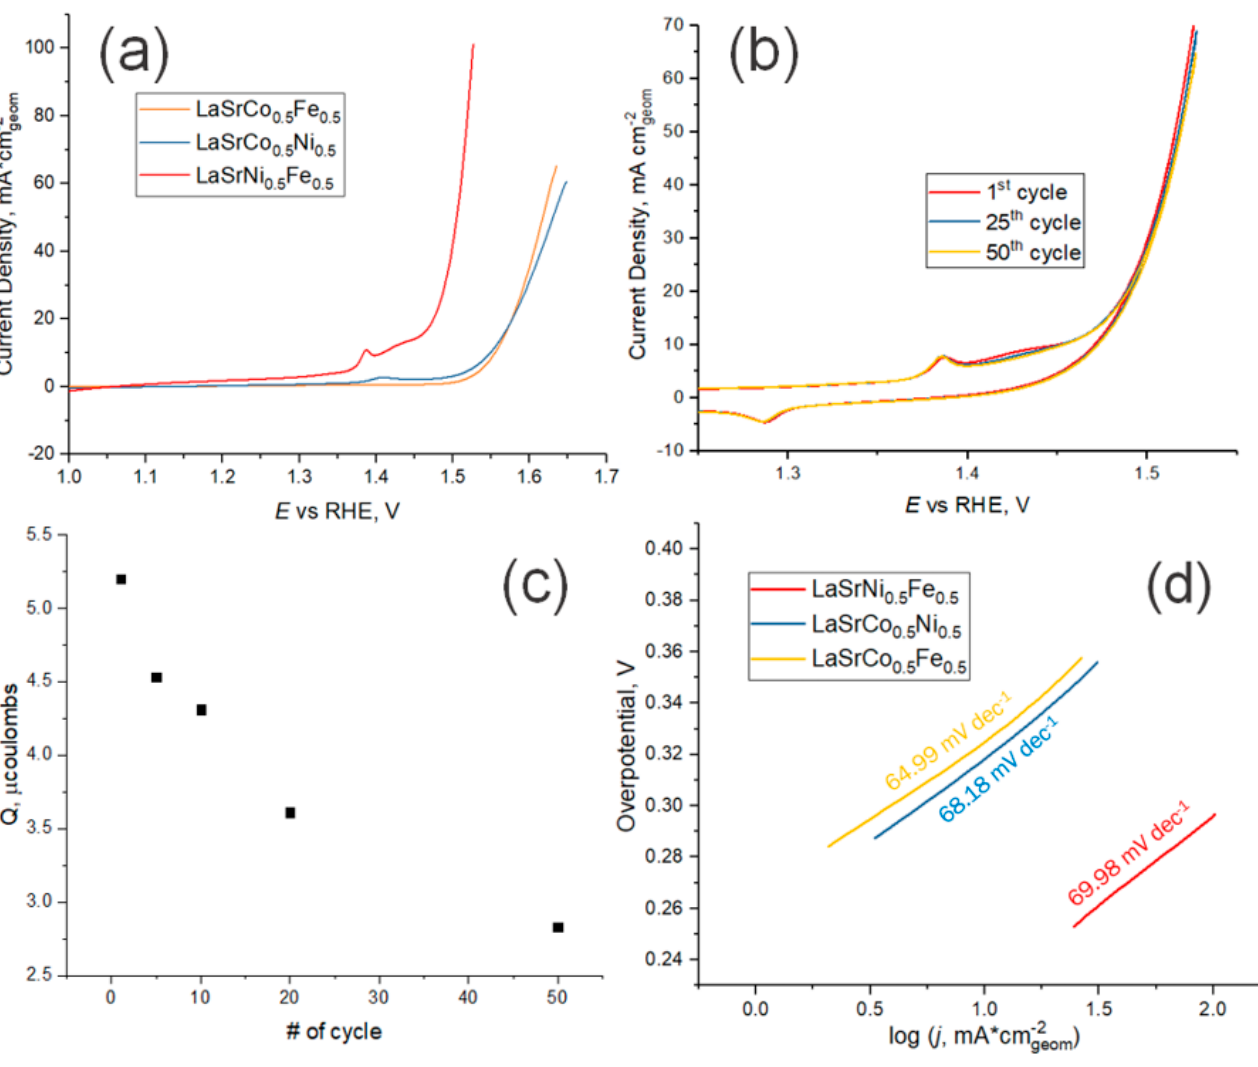
Figure 6. ( a ) Cyclic voltammetry activity tests (2nd cycle) for samples prepared using the USP method on GC electrode in 5M KOH (pH 14.69) at 10 mV s –1 ; ( b ) Fifty cycles of LSNF on GC in 5M KOH at 10 mV s –1 in the range of potentials from 1 to 1.55 V (vs. RHE); ( c ) Integrated charge